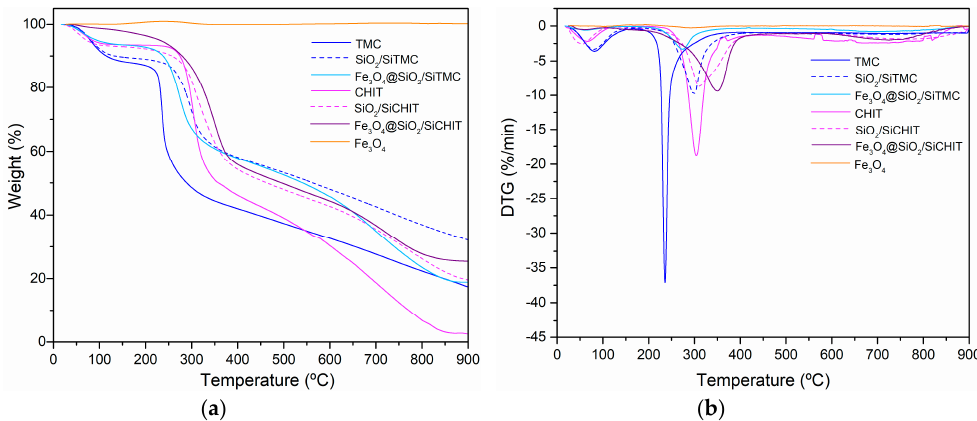
Figure 4. Curves of ( a ) TGA and ( b ) DTG of the biopolymers, siloxane hybrid materials prepared using the biopolymers, bare Fe 3 O 4 and the coated magnetic hybrid particles.